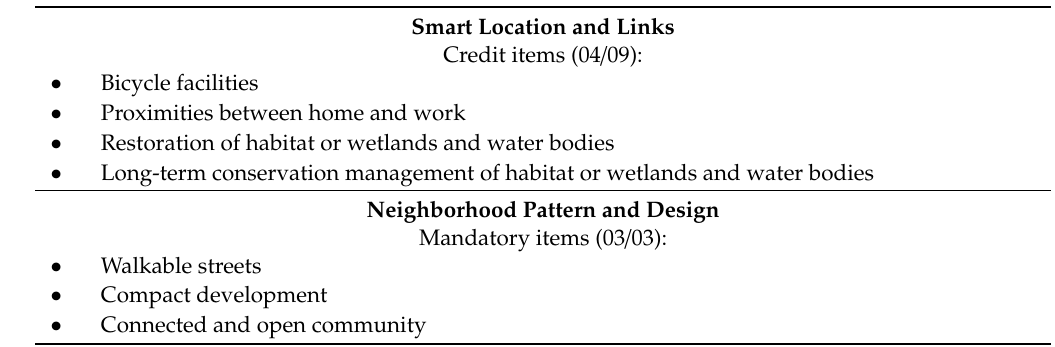
Table 7. The 47 potential sustainability